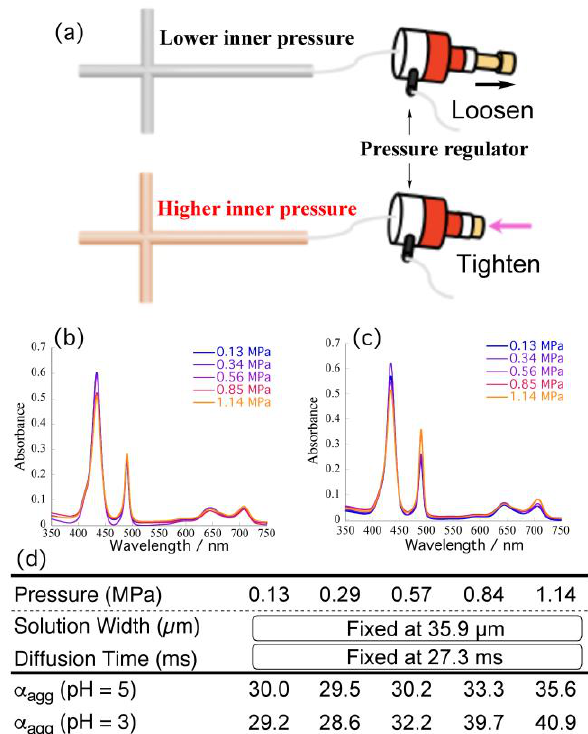
Figure 5. ( a ) Cartoon representation of the supramolecular polymerization of TPPS under the effect of back-pressure in the microflow channel. ( b , c ) UV–Vis spectra of TPPS recorded after increasing the back-pressure at pH ( b ) 5 and ( c ) 3 (under constant diffusion; i.e., v = 10 μL/min) (0.1 mm cell, r.t). ( d ) Aggregation efficiencies measured upon varying pressure under a constant proton diffusion effect (for the comparison plot, see Figure S1).